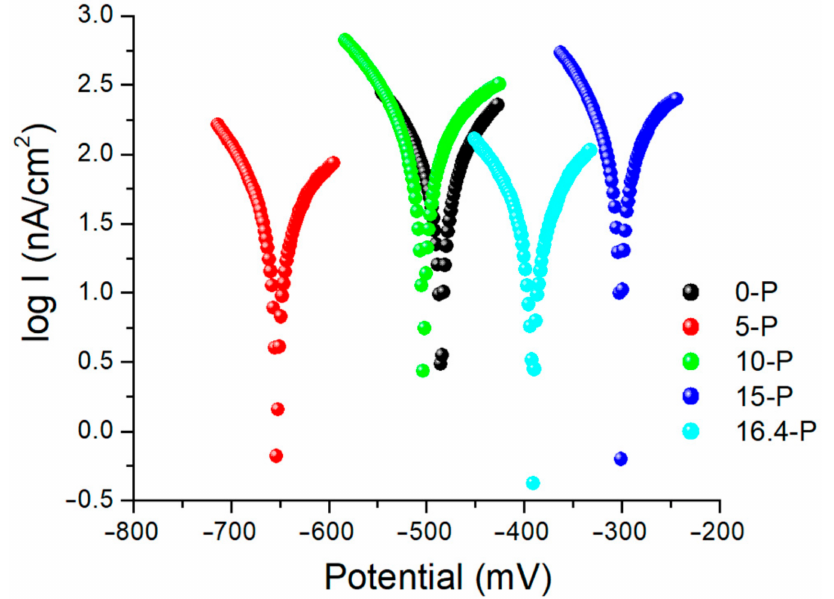
Figure 5. Comparative representation of the potential dynamics curves for the samples 0-P (black); 5-P (red); 10-P (green); 15-P (blue) and 16.4-P (light blue) analyzed after casting. The tests